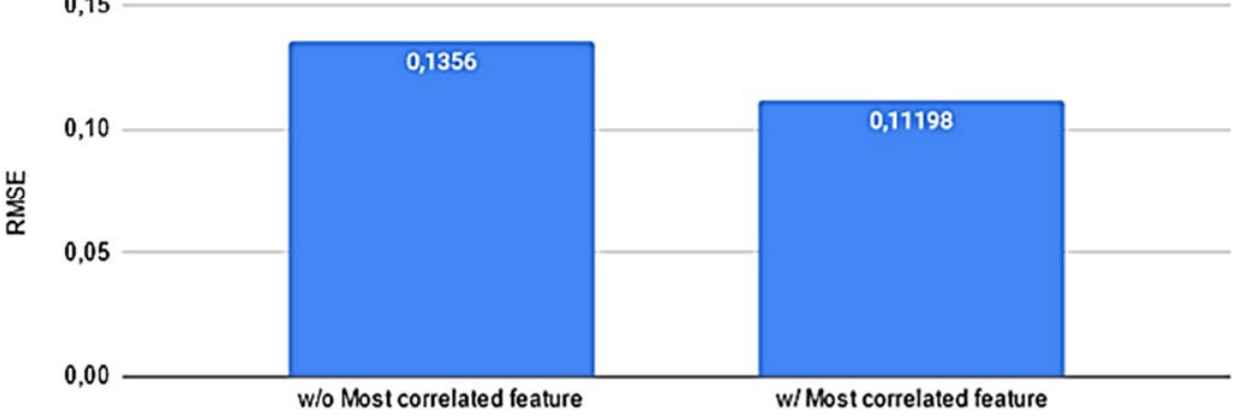
Figure 13. Average RMSE concerning the presence of the most correlated feature with the predicted variable calculated on 2 h prediction horizon for the validation set.